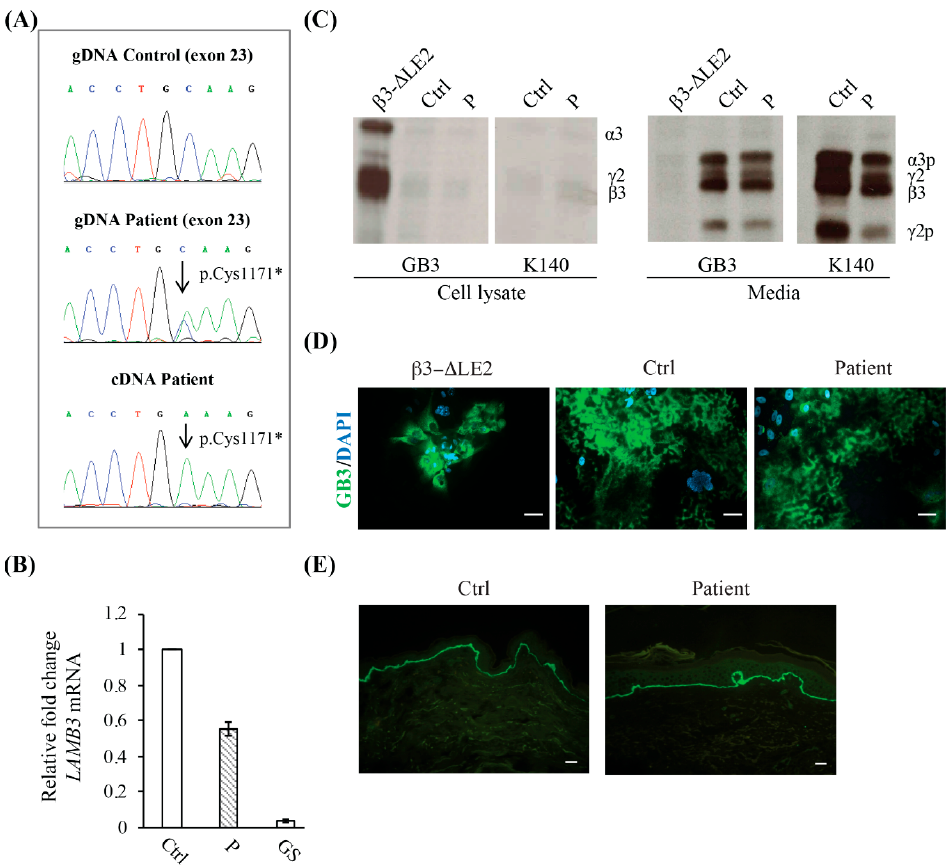
Figure 2. Molecular characteristics of the patient. ( A ) LAMB3 exon 23 sequence chromatogram of patient genomic DNA (gDNA) shows the p.Cys1171* compound heterozygous mutation (middle panel). A sequence chromatogram from a normal control is shown for comparison (upper panel). The